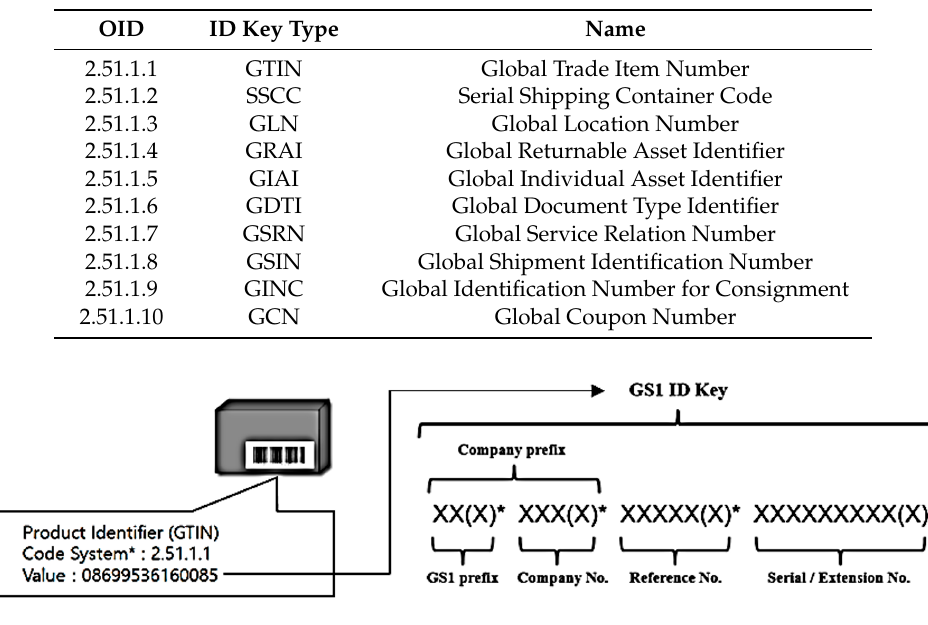
Figure 3. GS1 ID key value.